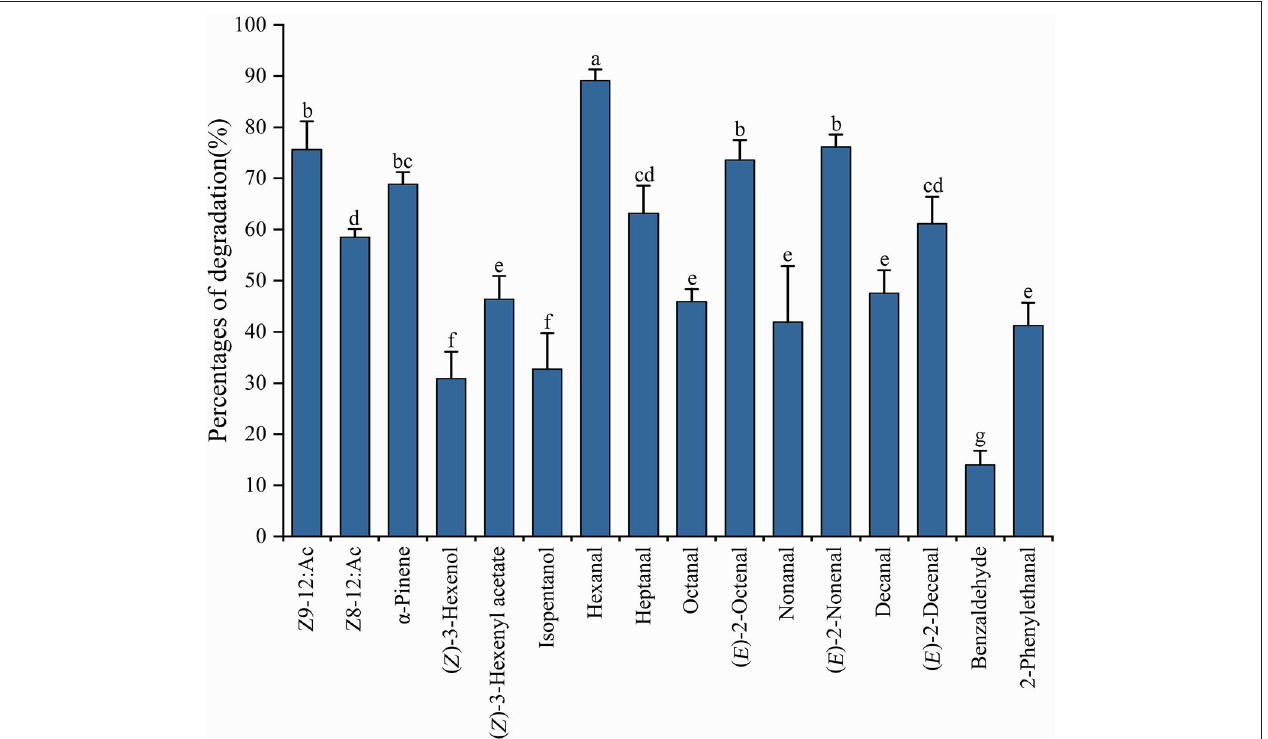
FIGURE 6 | Degradation percentages against various substrates using recombinant PiGSTd1. Columns with different lowercase letters indicate significant differences at the 0.05 level by Tukey’s HSD multiple range